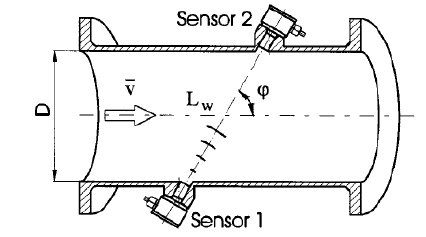
Fig. 1 Ultrasonic flowmeter – principle [2].